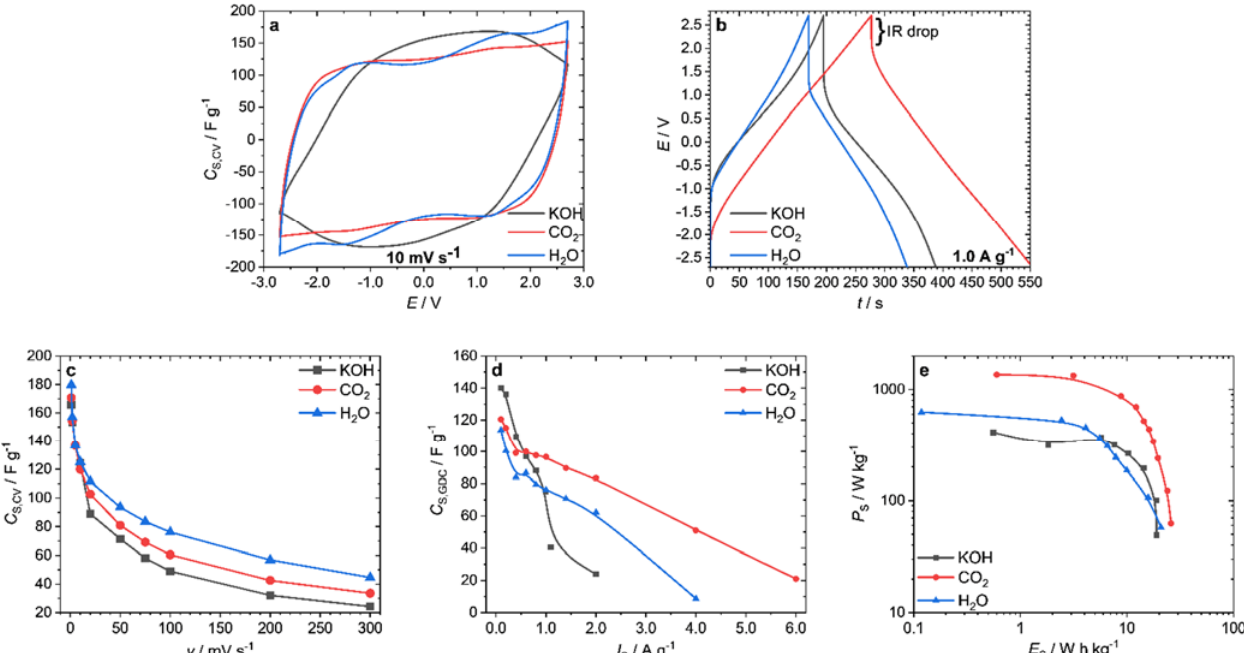
Figure 2. Electrochemical measurements of the EDLCs: CVs at a scan rate ν of 10 mV s − 1 ( a ), GDC at a specific current I S of 1.0 A g − 1 ( b ), C S,CV at different scan rates ν ( c ), C S,GDC at different current densities I S ( d ), and Ragone plot calculated from GDC per device ( e ).